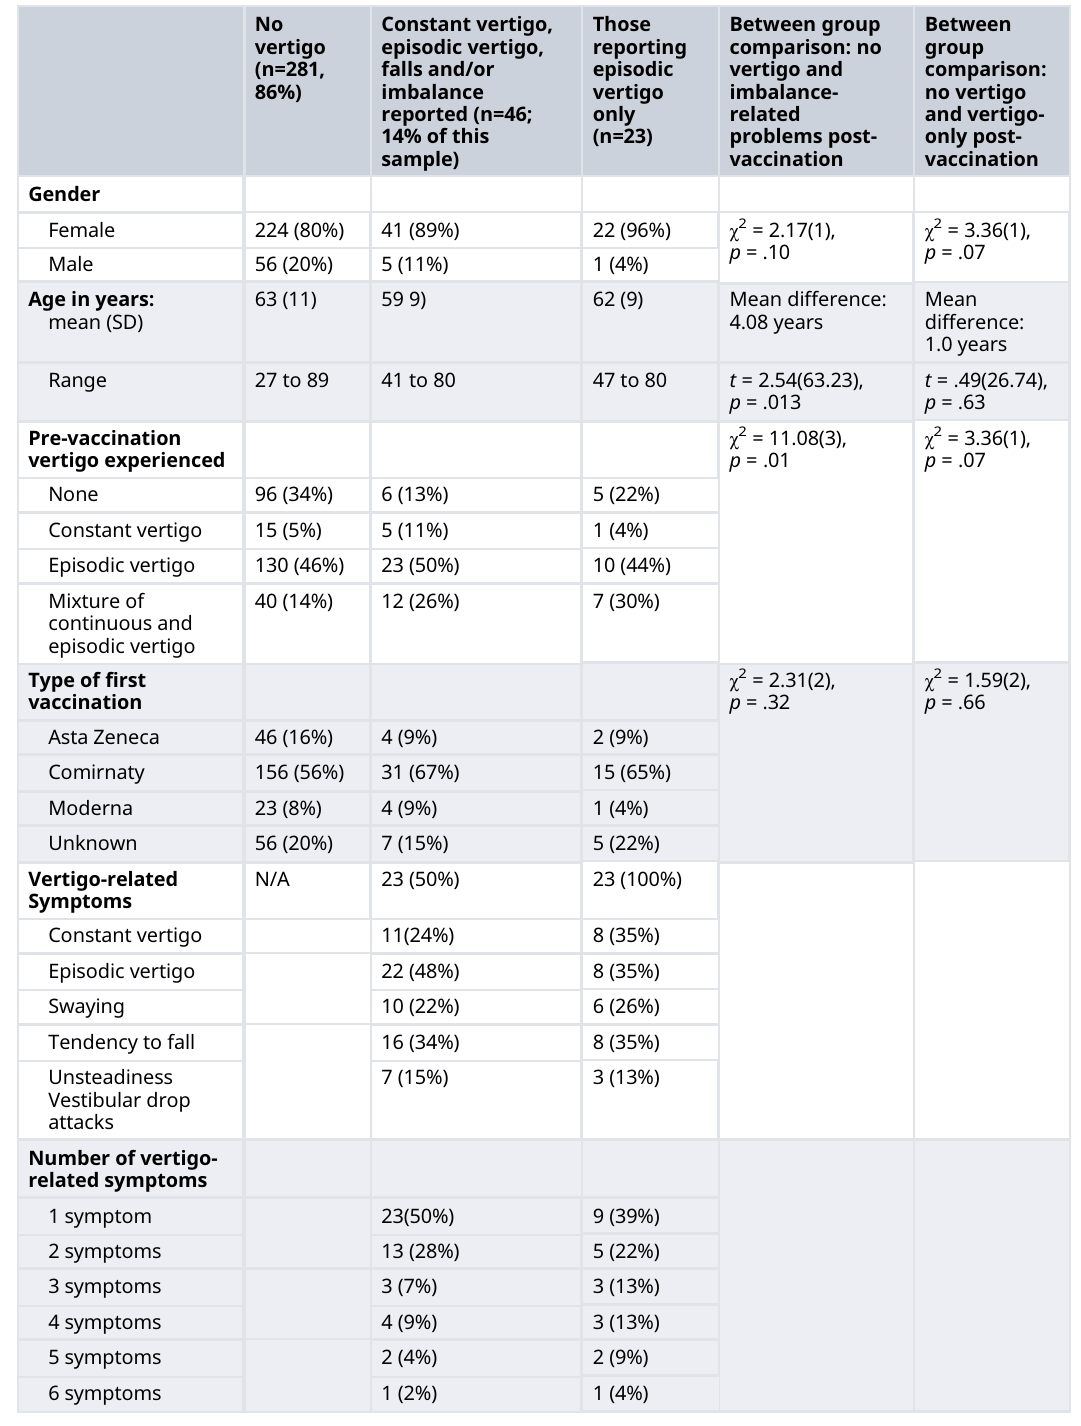
Those reporting episodic vertigo only (n=23)